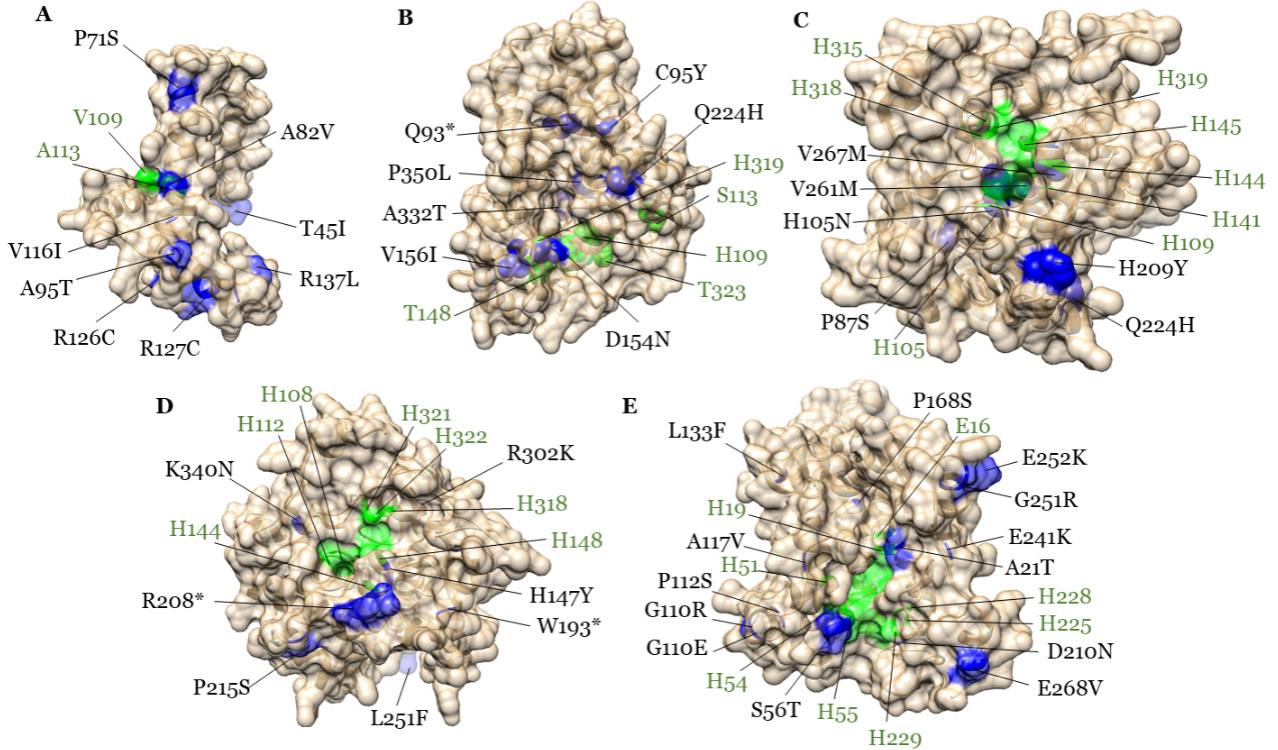
Figure 3. Homology modeling of the five GmFAD2-2 proteins and corresponding identified EMS mutations. Mutated residues on the five GmFAD2-2 proteins identified by Tilling-by-Sequencing + were mapped on the five GmFAD2-2 protein homology models. Homology modeling of the GmFAD2-2A ( A ), GmFAD2-2B ( B ), GmFAD2-2C ( C ), GmFAD2-2D ( D ), and GmFAD2-2E ( E ) predicted proteins. The identified mutations and corresponding amino acid changes are shown on blue. Putative di-iron binding sites residues and substrate-binding pocket are shown in green.